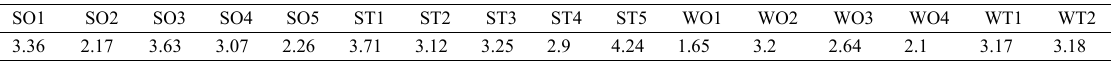
Table 6: QSPM values